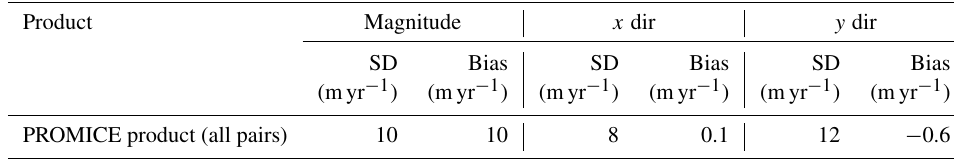
Table 6. Statistics of the validation of the PROMICE product (spanning 24d) over stable ground. Number of pixels included in the analysis: > 142 × 10 6